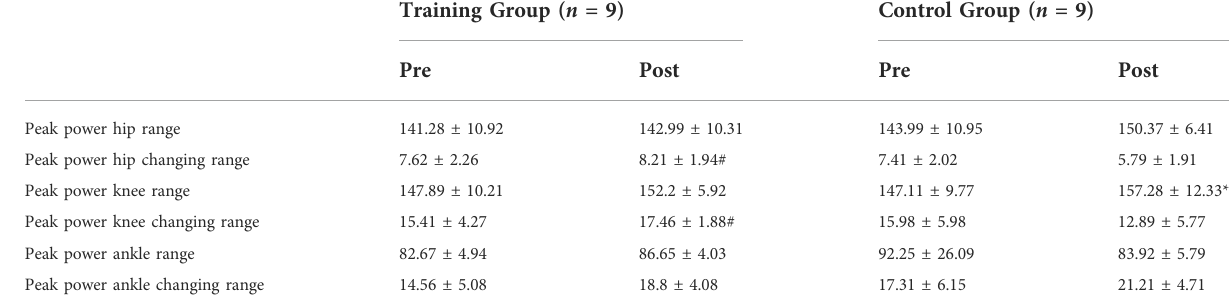
TABLE 7 Hip, knee, and ankle range parameters ( °